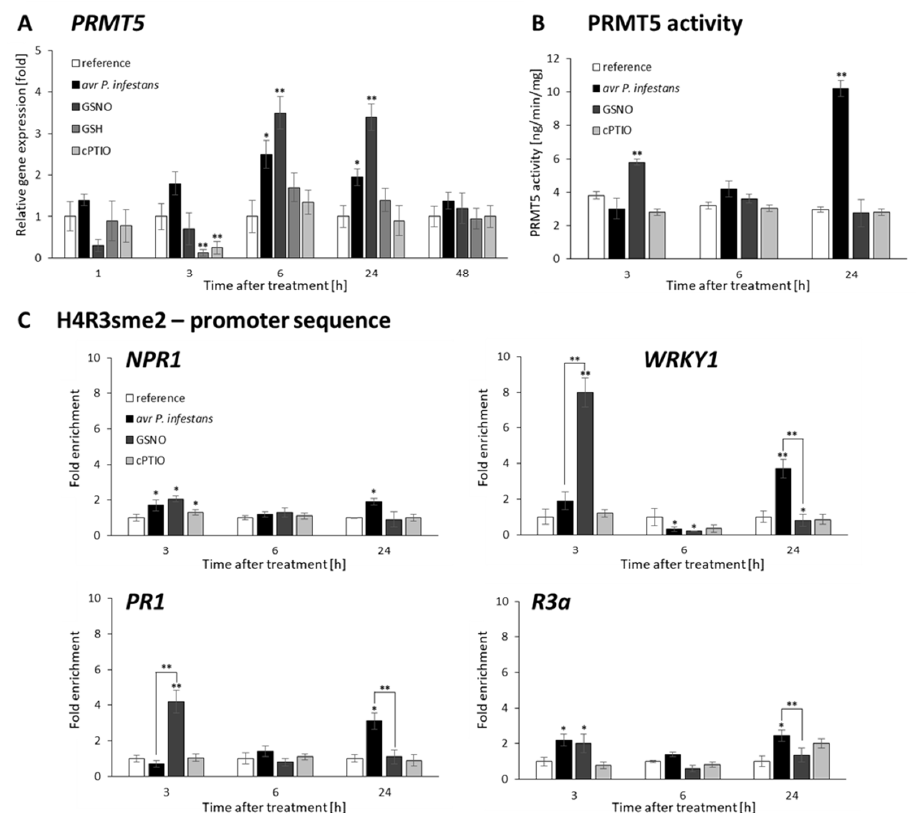
Figure 5. NO-mediated changes in histone arginine methylation PRMT5 expression ( A ), PRMT5 activity ( B ) distribution levels of H4R3sme2 on the promoter of NPR1 , WRKY1 , PR1 , and R3a , respectively ( C ). RT-qPCR and ELISA tests were performed in potato leaves (at 1–48 h) after treatment with GSNO, GSH, cPTIO, water, or avr P. infestans inoculation, respectively. ChIP–qPCR analyses were performed in potato leaves at selected time points (3–24 h), after treatment with GSNO, GSH, cPTIO, water, or avr P. infestans inoculation, respectively. Data are presented as X-fold enrichment [55]. The relative amounts of immunoprecipitated chromatin fragments (as determined by real-time PCR) from the above variants of treatment were compared with the reference (arbitrarily set to 1). Each experiment included at least three independent measurements per sample. P values for each sample combination were calculated using ANOVA and mean values were compared using the Tukey–Kramer test ( α = 0.05 (*) and α = 0.01